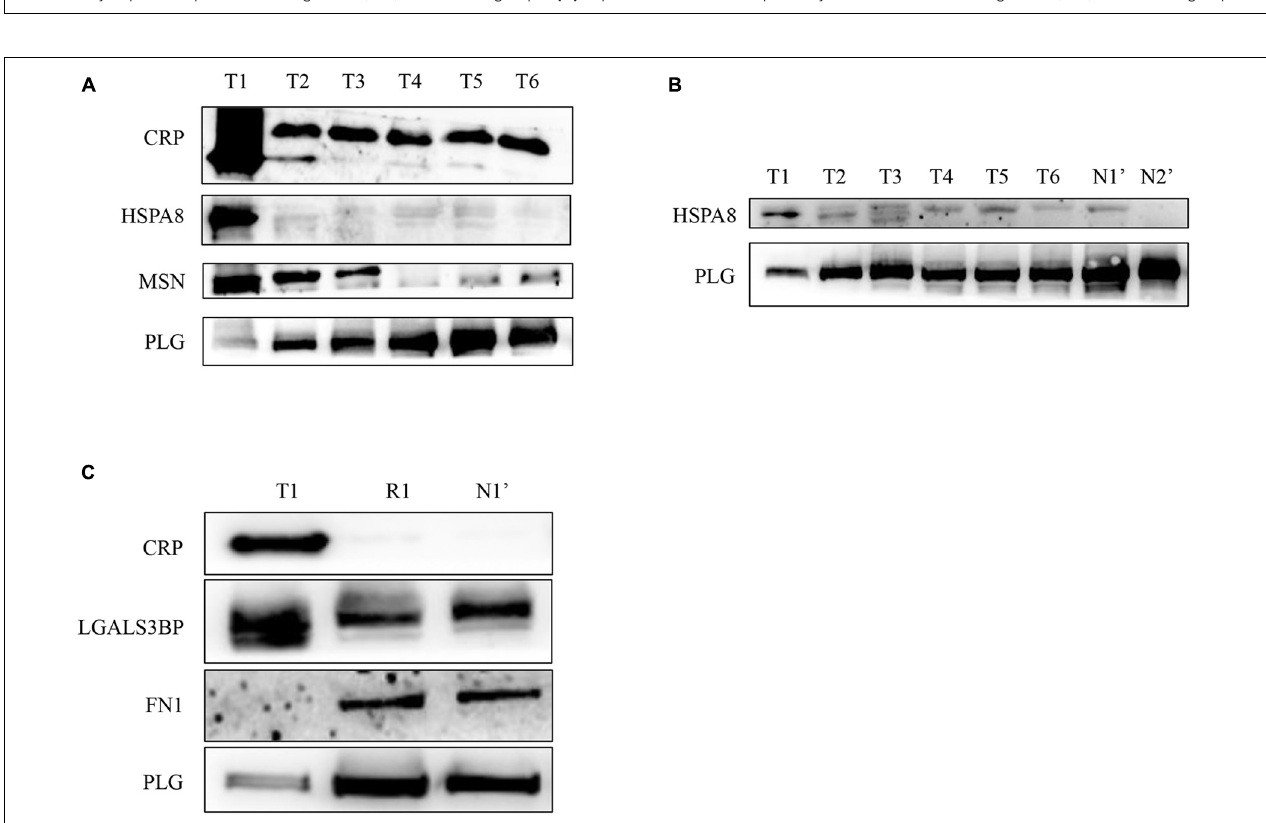
FIGURE 4 | Verification of the differentially expressed proteins in plasma exosomes obtained from the patient with EBV-HLH by western blotting. (A,B) The expression levels of differentially expressed proteins during the treatment of the patient (T1–T6 represents the patient’s plasma exosome samples from the acute stage before treatment to 3 weeks after treatment and discharge, N1’ is the sample of his twin brother, N2’ is another healthy control sample). (C) The plasma exosomal protein expression level of the patient in the acute phase (T1) and 1 year after rehabilitation (R1) and that of the twin brother (N1’).